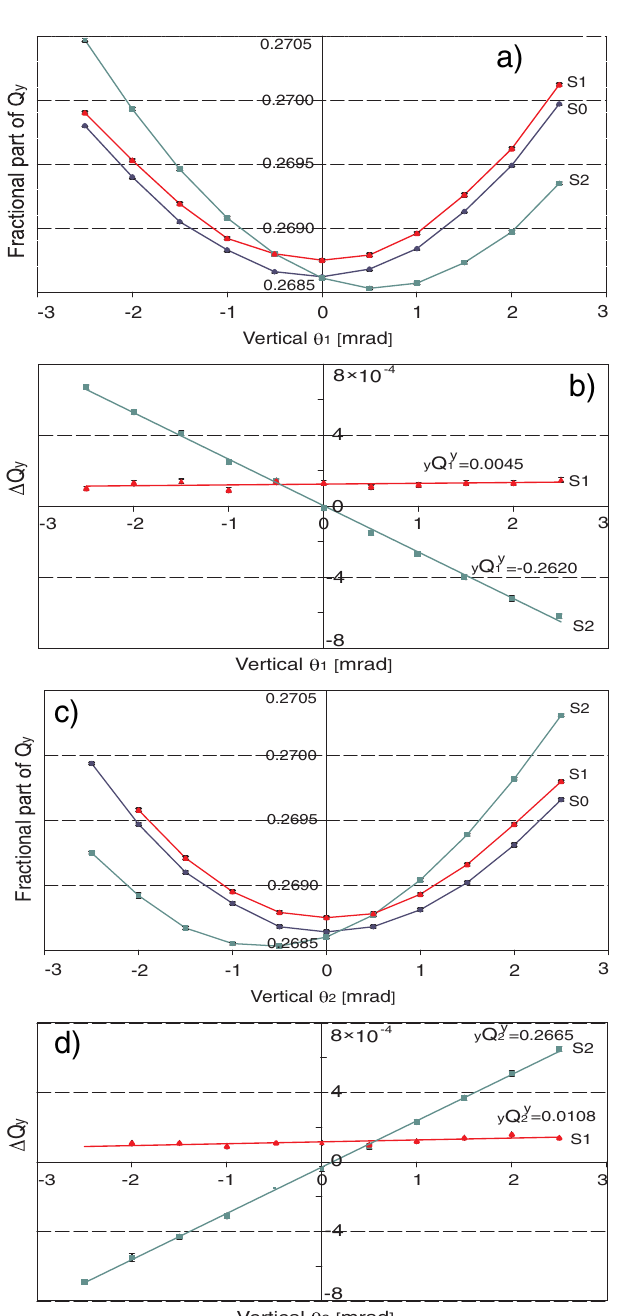
FIG. 7. (Color) Measured tune response for several strengths of the skew error deforming the closed orbit with the first steerer (a) and differential tune response (b). In (c) and (d) the same quantities were obtained varying the second